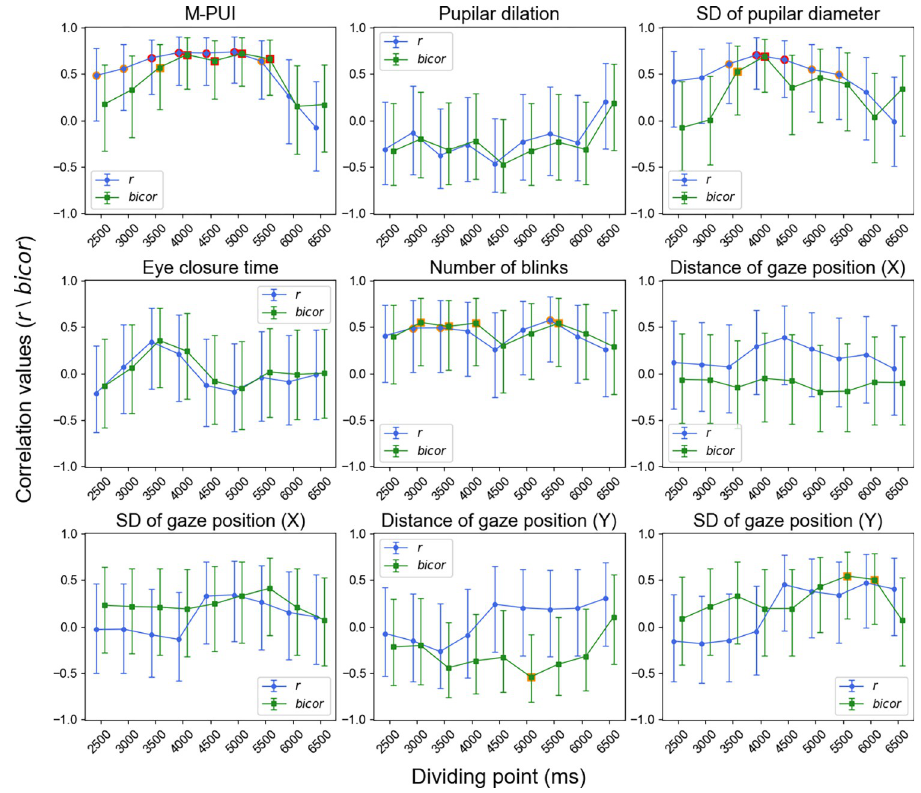
Fig 8. Dividing-point-dependent correlation of FP effect on RT for M-PUI and eye movement indices. The red circles indicate the dividing points that reached a corrected significance level of .0055. The orange circles indicate the dividing points that reached an uncorrected significance level of .05. Error bars represent 95% credible